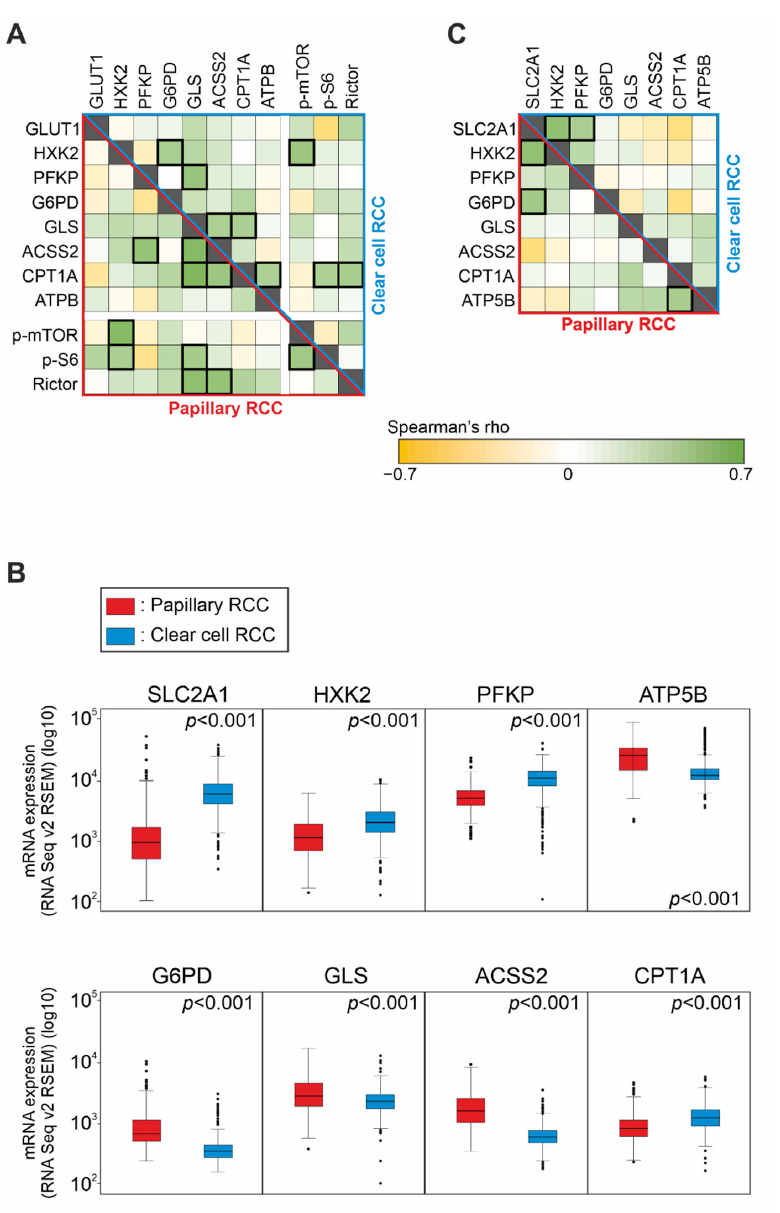
Figure 3. Expression and correlation of the mTOR and metabolic pathway markers in papillary (PRCC) and clear cell renal cell carcinomas (CCRCC). ( A ) Correlation between the protein expression of GLUT1, HXK2, PFKP (glycolysis markers), G6PD (pentose phosphate pathway marker), GLS (glutaminolysis marker), ACSS2 (marker for acetate consumption), CPT1A (fatty acid β -oxidation marker), ATPB (OXPHOS marker), p-mTOR, p-S6, and Rictor (mTOR markers) in papillary (lower, red triangle) and in clear cell (upper, blue triangle) RCCs based on our IHC analysis. Green color indicates a negative, yellow color labels a positive correlation. Strong correlations (Spearman’s R > 0.4 and p < 0.05) are marked with a thick outline. ( B ) The mRNA expression of metabolic pathway markers in papillary and clear cell RCCs according to the TCGA KIRP (PRCC) and KIRC (CCRCC) datasets. SLC2A1 and ATP5B are mRNAs coding for GLUT1 and ATPB, respectively. Two-sided p values were considered statistically significant below 0.05 (Mann–Whitney U test). ( C ) Correlation between the mRNA expression of metabolic pathway markers in papillary (lower, red triangle) and clear cell (upper, blue triangle) RCCs according to the TCGA datasets. Green color indicates a negative, yellow color labels a positive correlation. Strong correlations (Spearman’s R > 0.4 and p < 0.05) are marked with a thick